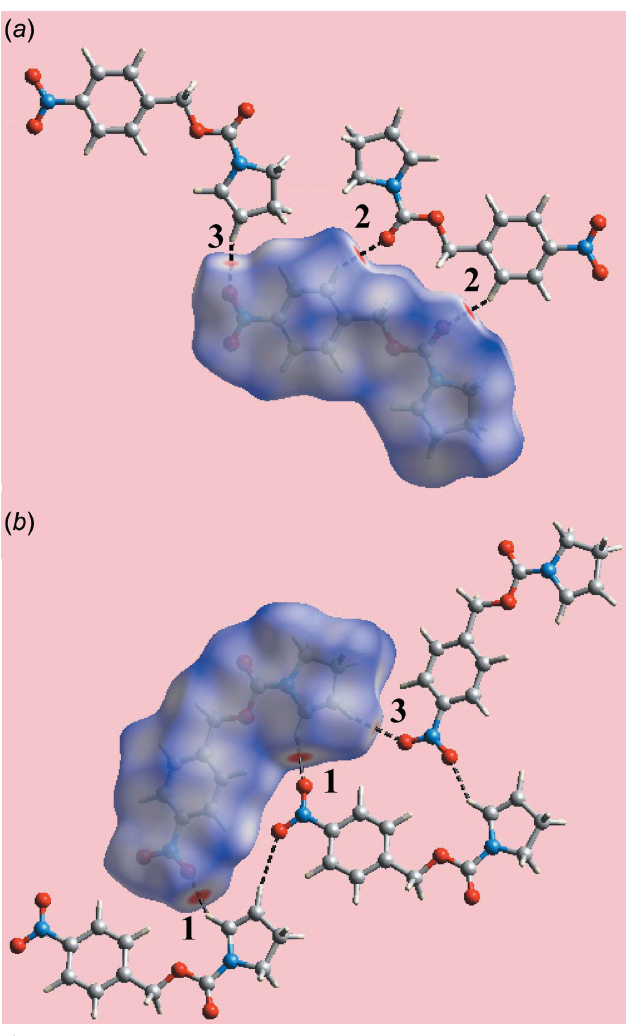
Figure 3 Two views of the Hirshfeld surface for (I) mapped over d norm in the range (cid:5) 0.225 to +1.393 au, showing intermolecular C—H (cid:2)(cid:2)(cid:2) O contacts as black dashed lines.